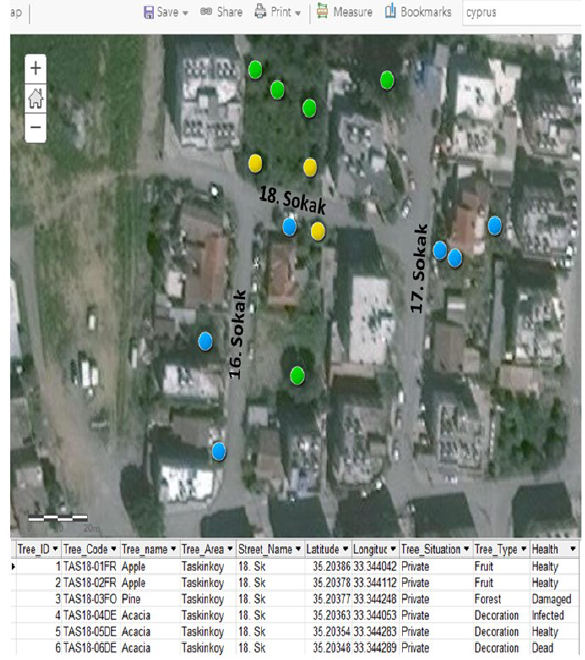
Figure 3. Representation of Trees with ArcMap.